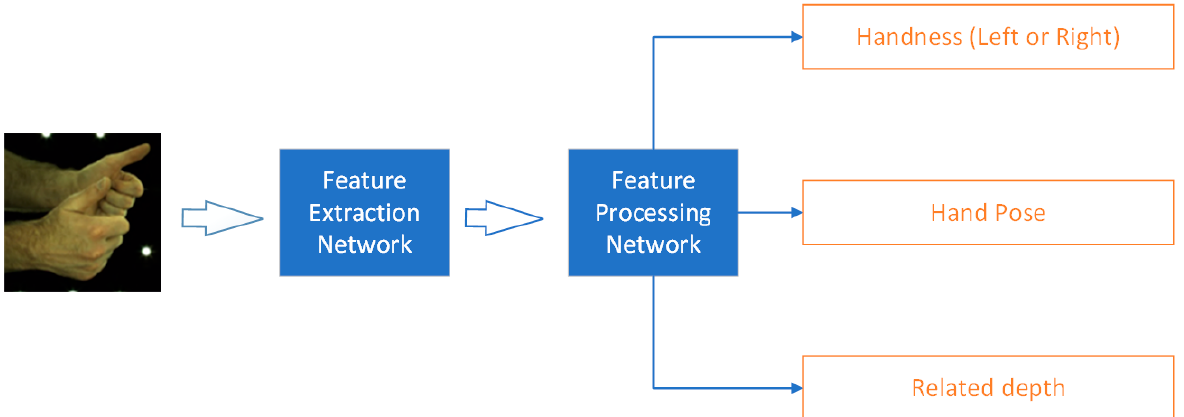
Figure 1. The basic operating principle of the original InterNet. For the outputs, the “handness” means the existence possibility of right hand and left hand, as the output of the fully connected layer; the “Hand Pose” means the hand pose of the right hand and left hand from transferred 2D to 3D hand key-points position; the “Related depth” means the root point related depth of two hands .